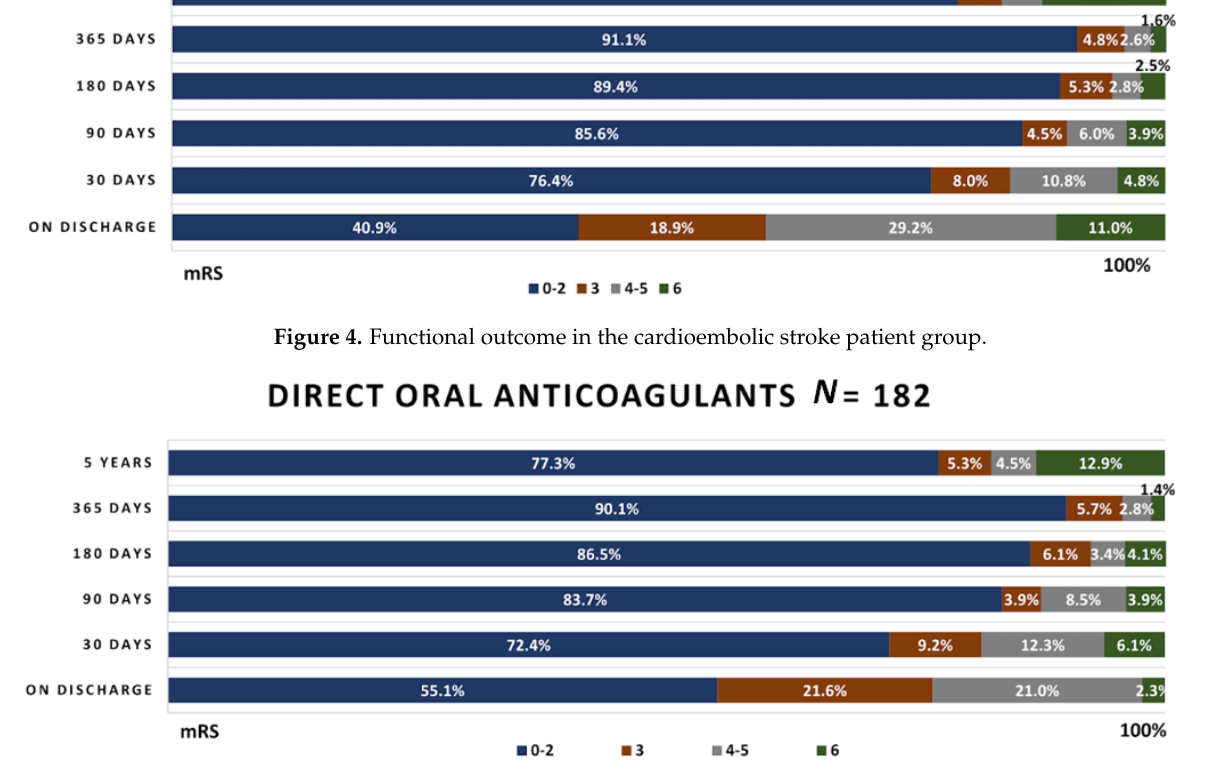
Figure 5. Functional outcome in patients taking DOACs.